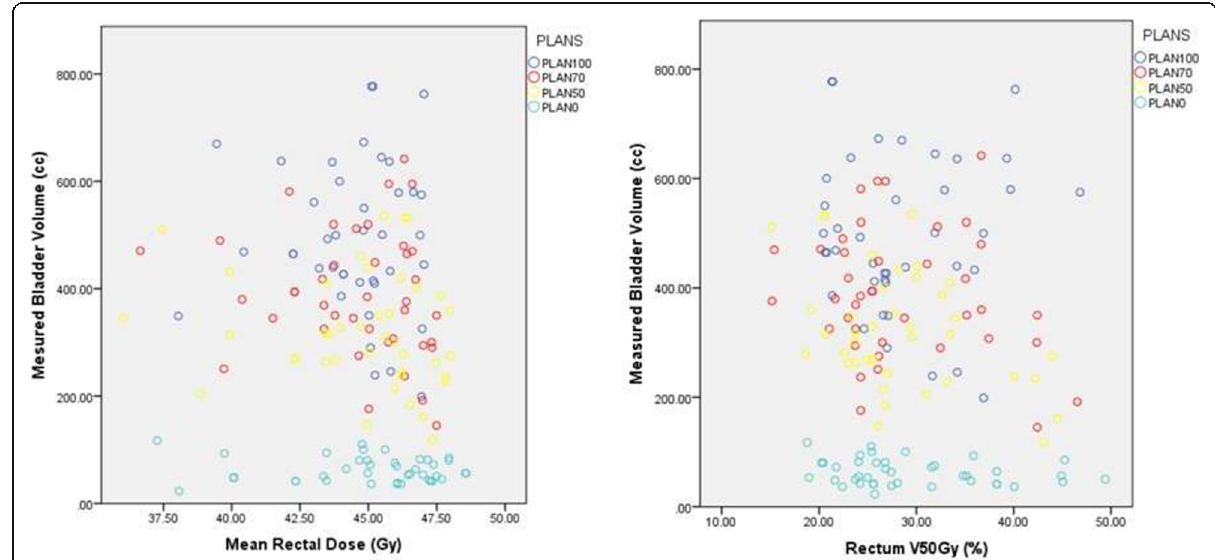
Fig. 2 Scatterplot showing correlation between bladder volumes and corresponding mean dose and V 50 Gy of rectum for different